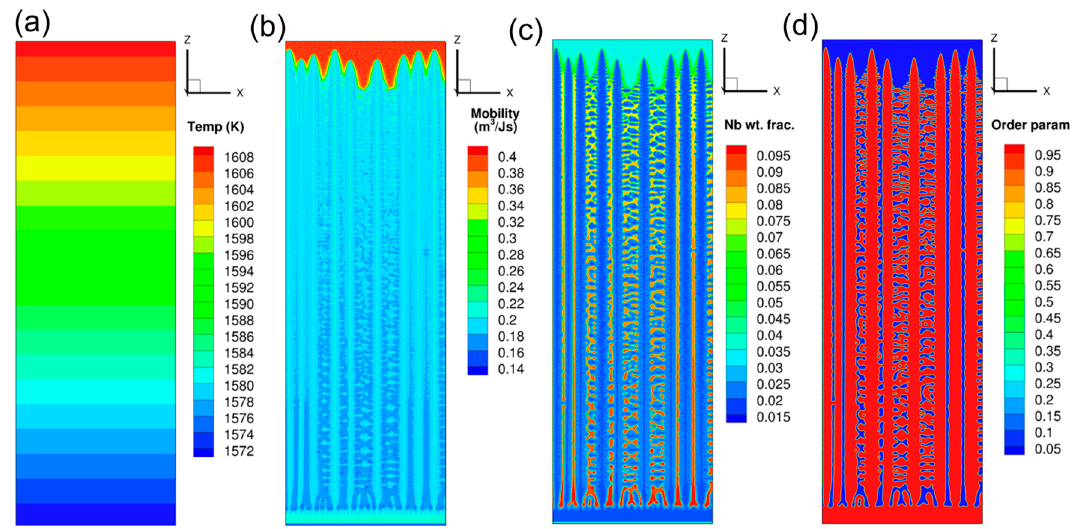
Figure 12. 2D simulations of solidification using random nucleation with an initial s-l interface temperature of 1630 K, G = of 2.6 × 10 6 K/m, D = 1 × 10 − 9 m 2 /s and sd = 500. Simulation volume 5 μ m × 5 µ m × 15 µ m. Contour plots showing the distribution of ( a ) temperature, ( b ) phase field mobility, ( c ) Nb concentration and ( d ) order parameter.